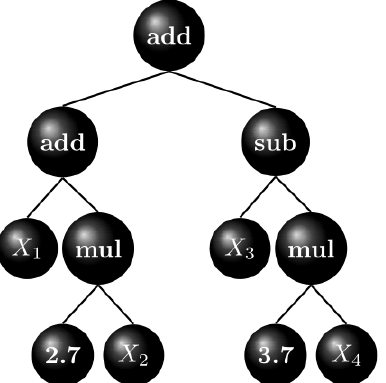
Figure 4. The example of computer program represented as three